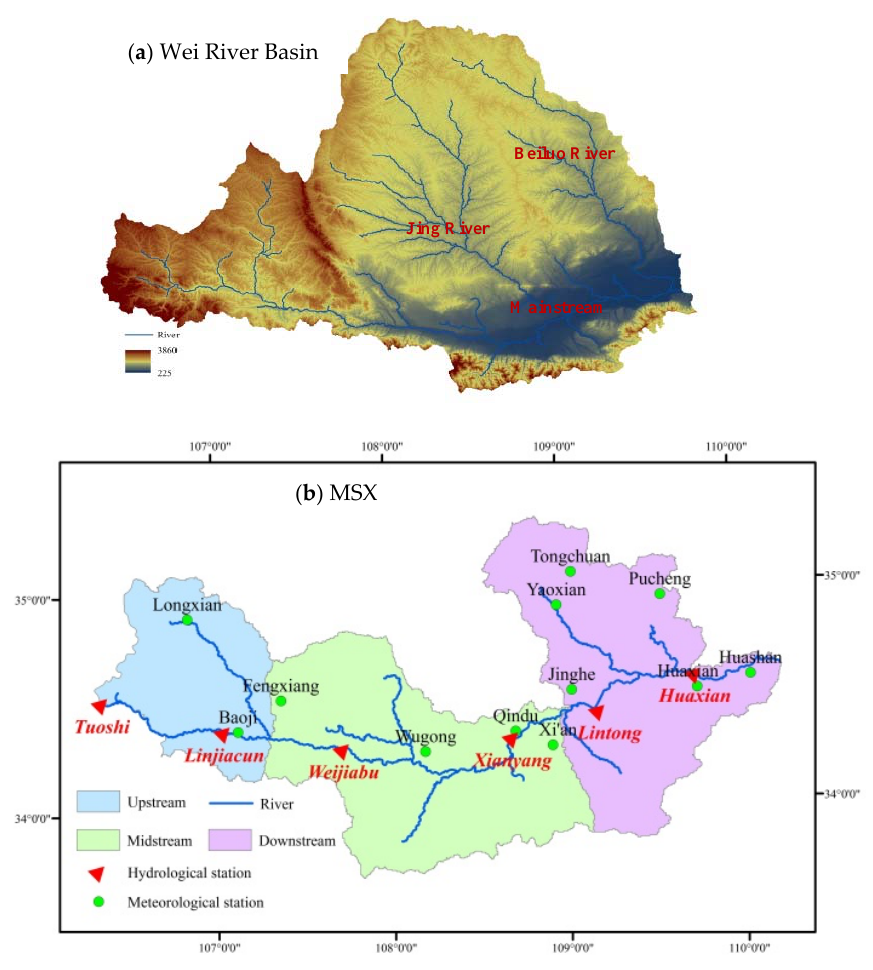
Figure 1. ( a ) The digital elevation map of Wei River Basin, which can be divided into the Mainstream, Jing River, and Beiluo River Basins; ( b ) Overview map of Mainstream of the Wei River in Shaanxi Province (MSX); Linjiacun is the hydrological control station at upstream, Xianyang is the hydrological control station at midstream, and Huaxian is the hydrological control station at downstream.